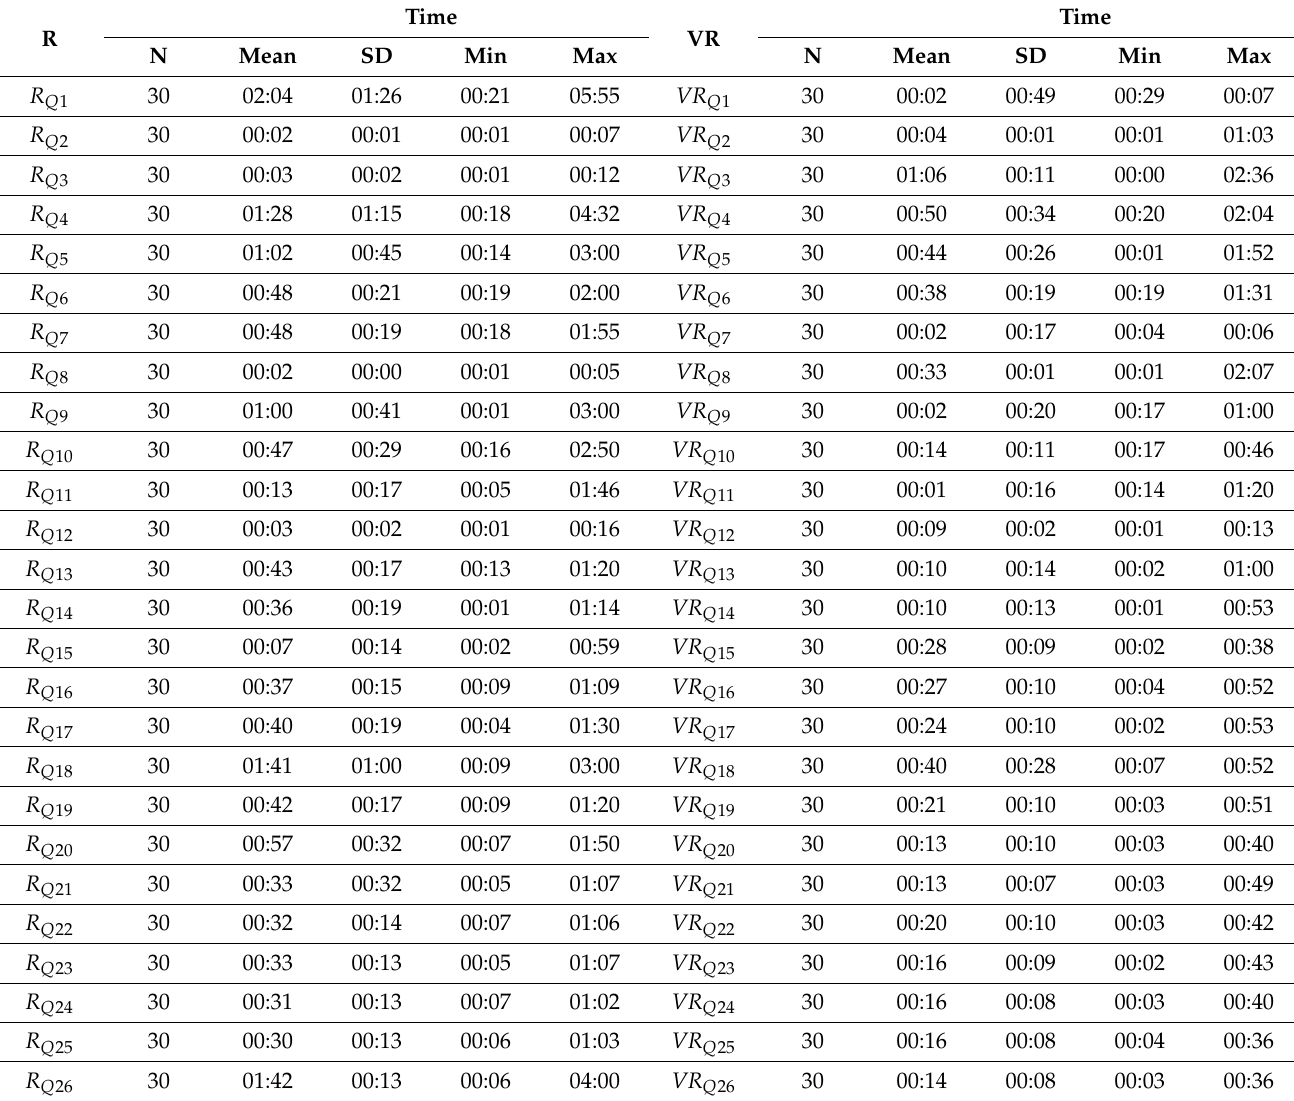
Table A1. Descriptive Statistics for time to complete the questions using R and